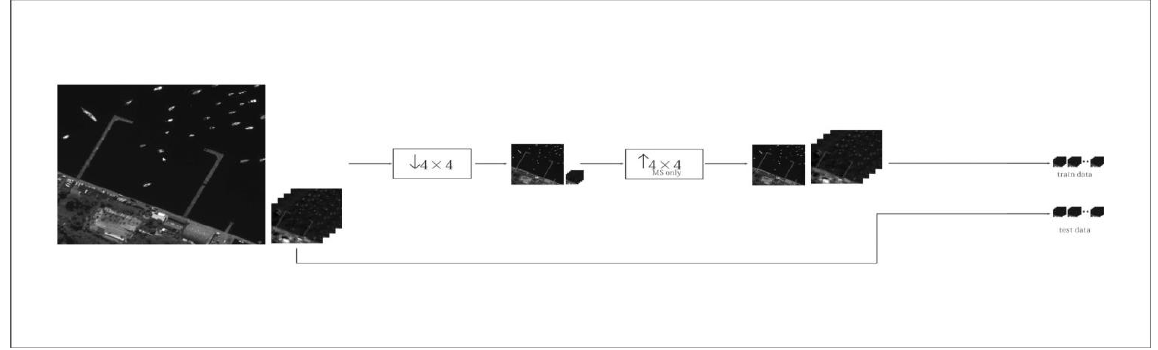
Figure 2. Training process based on the Wald protocol